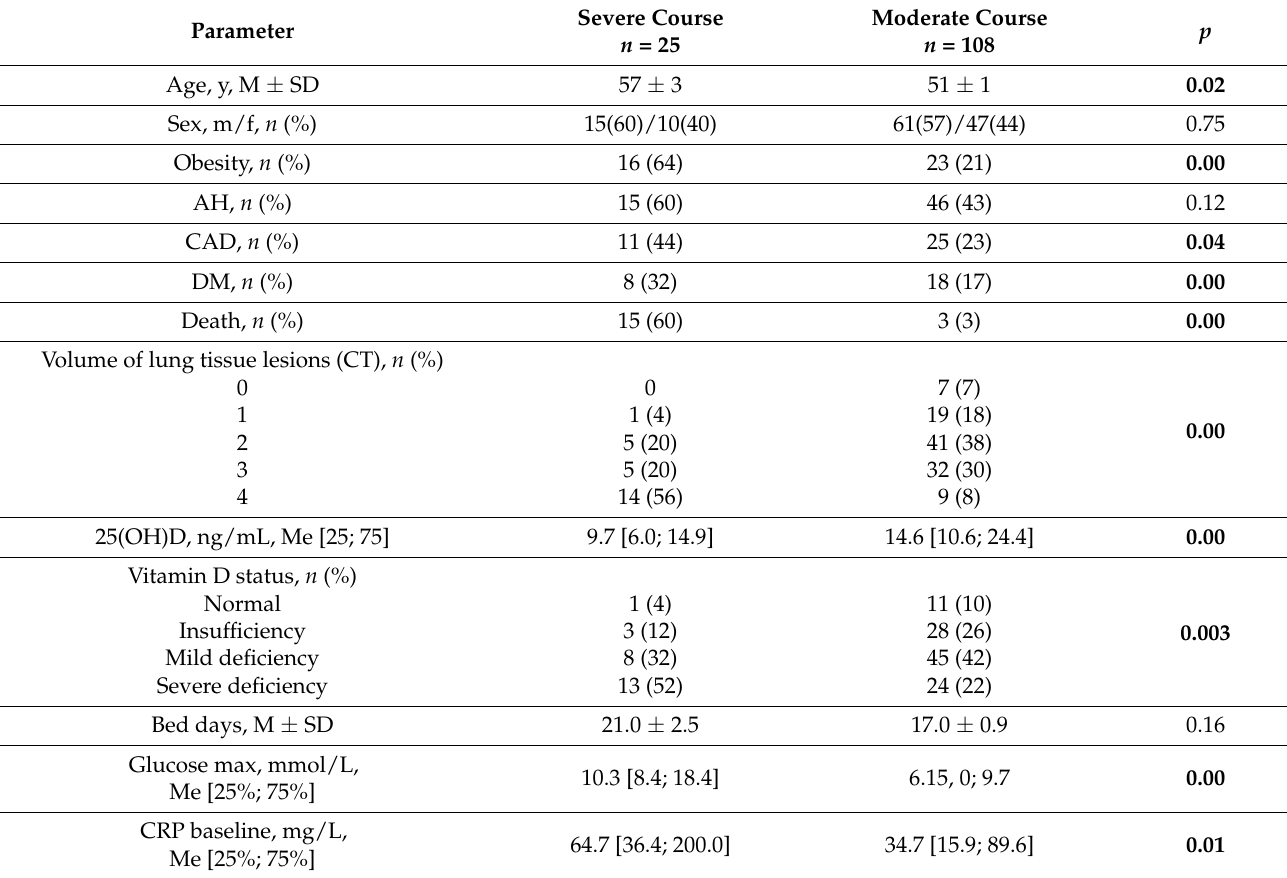
Table 1. Patients’ characteristics in relation to COVID-19